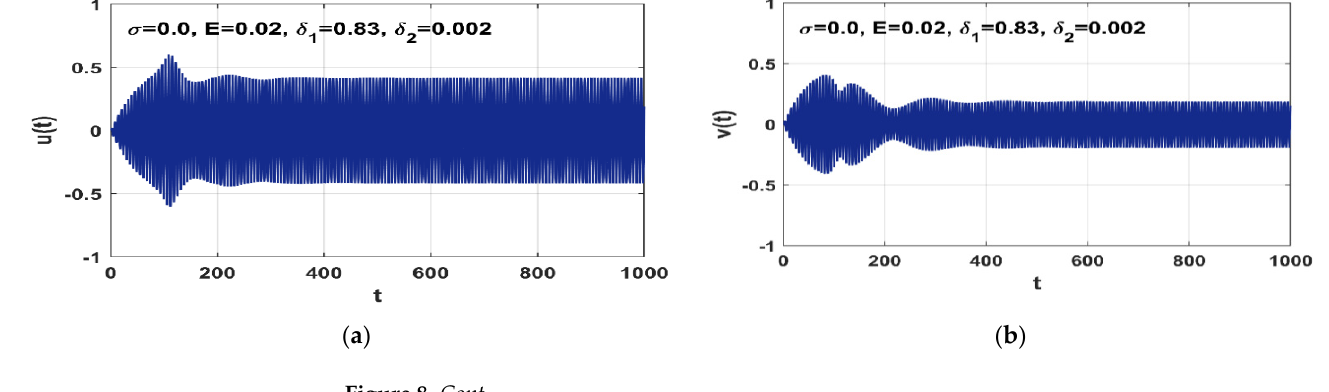
( f ) Figure 8. Periodic time-response, Poincaré-map, and frequency-spectrum of the controlled Jeffcott- rotor according to Figure 7 (i.e., at 𝜎 = 0, 𝛿 (cid:2869) = 0.83, 𝛿 (cid:2870) = 0.002 ) when 𝐸 = 0.02 : ( a , b ) the normal- ized temporal oscillations 𝑢(𝑡) and 𝑣(𝑡) in 𝑋 and 𝑌 direction, ( c , d ) the corresponding Poincaré- map, ( e , f ) the corresponding frequency-spectrum.